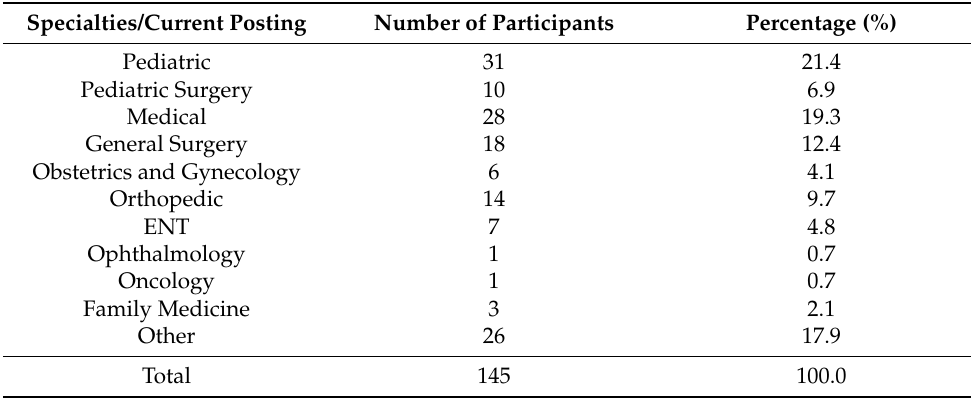
Table 1. Distribution of respondents’ specialty/current